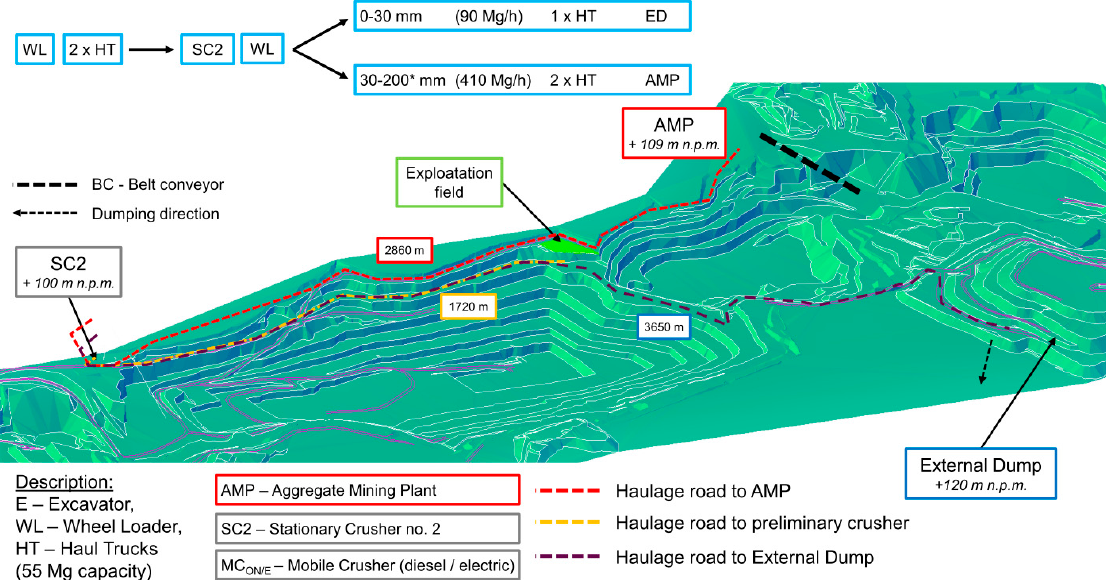
Figure 4. Primary crusher locations in the analyzed mine—Decision Variants no. 3.